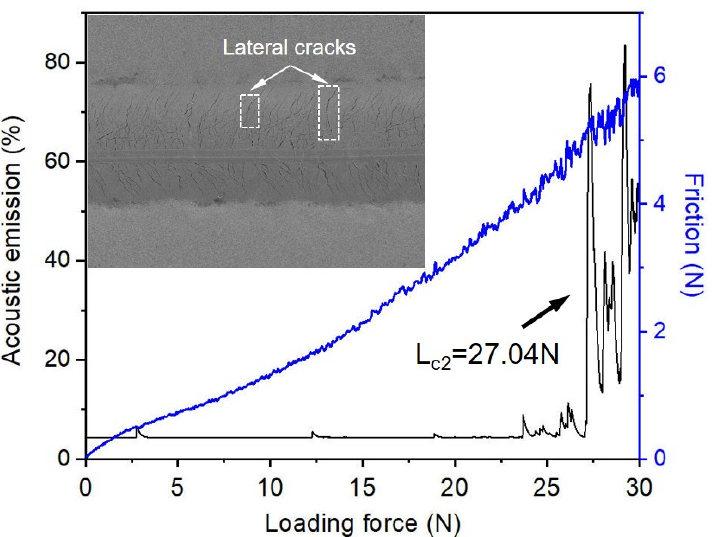
Figure 10. Scratch morphology and acoustic emission curve of coating at 100 W power.